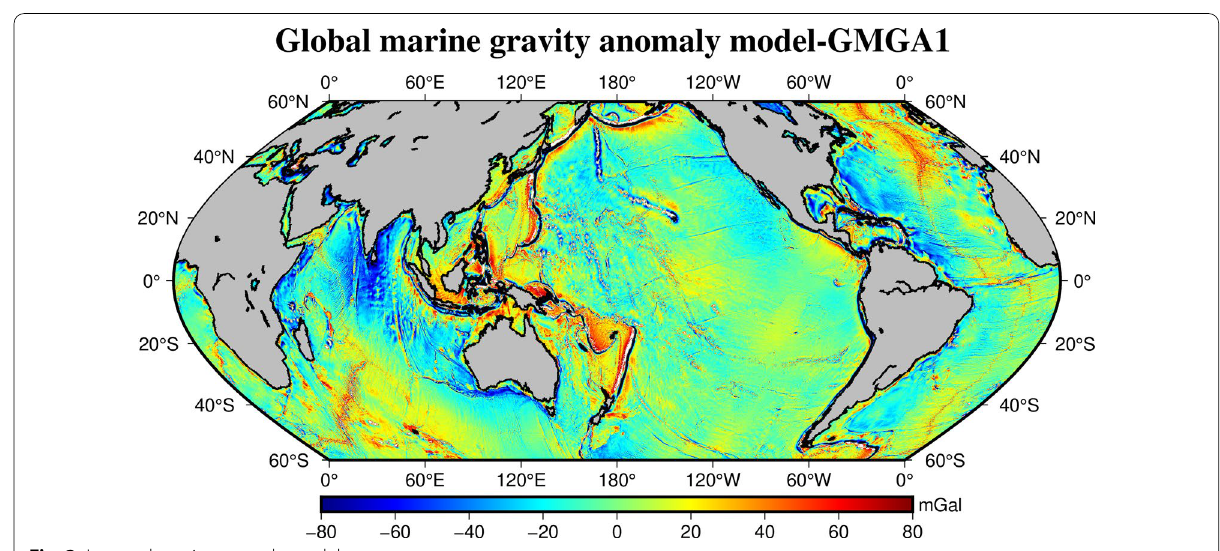
Fig. 3 Inverted gravity anomaly